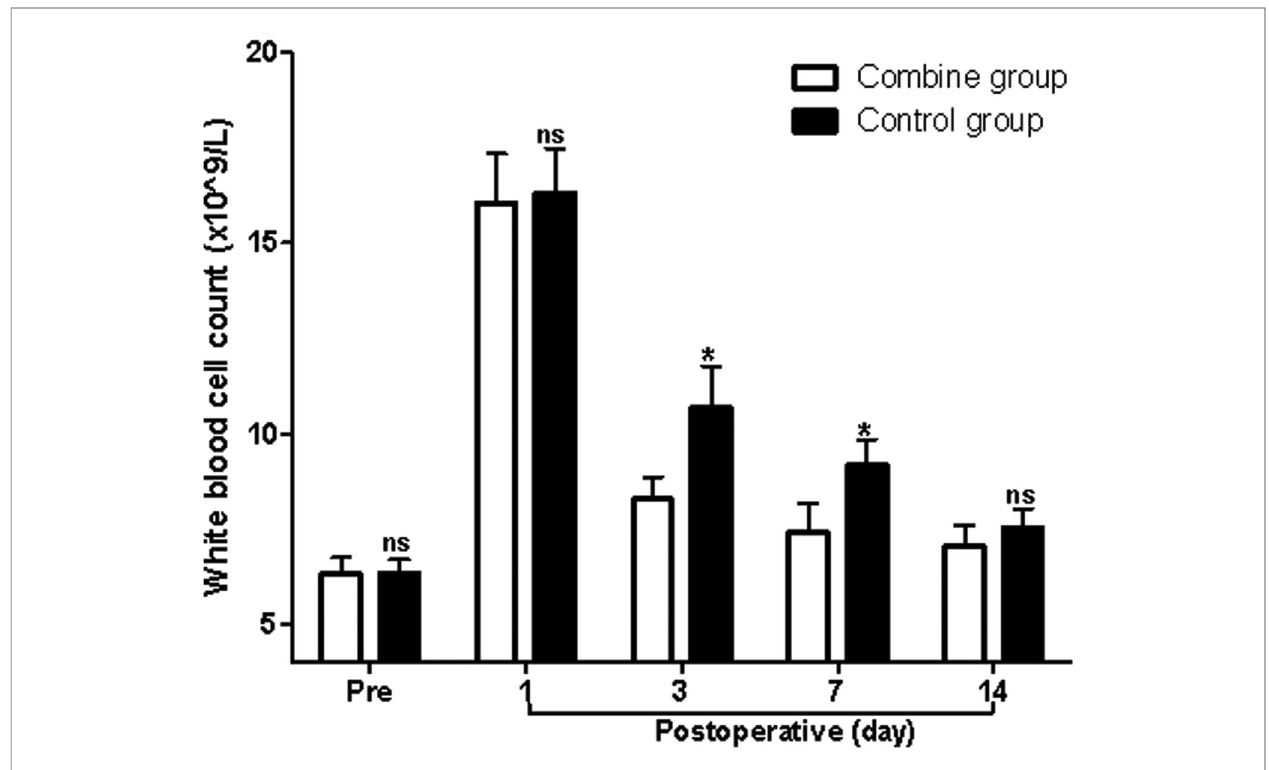
FIGURE 2 | Comparison of white blood cell count at different times in patients of two groups. Note: Compared with the combine group, ns p >0.05 and * p